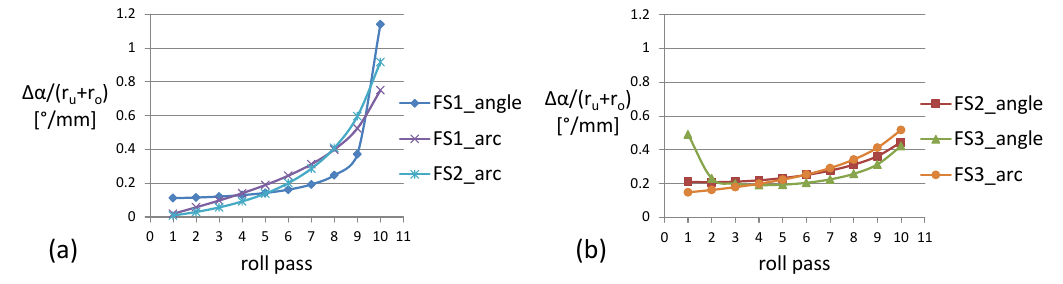
∆ α /(r Figure 18. ∆α/(r u + r o ) at each roll pass of the forming sequences. Figure 18. u + r o ) at each roll pass of the forming sequences.